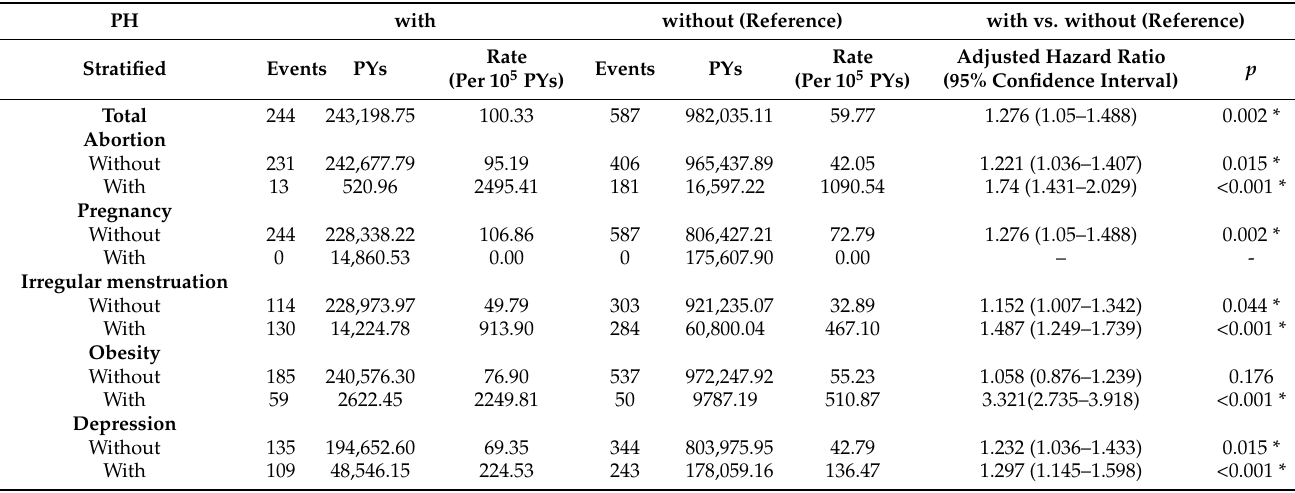
Table 3. Factors of premenstrual syndromes stratified by variables by using Cox